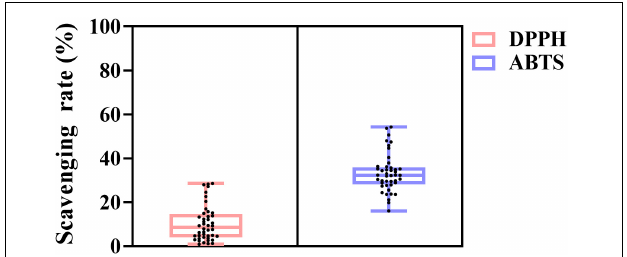
FIGURE 2 | Antioxidant activity of L. plantarum strains. The light pink box plot and light blue box plot represent DPPH radical scavenging activity and ABTS radical cation scavenging activity, respectively. The black dots indicate the distribution of 44 strains.